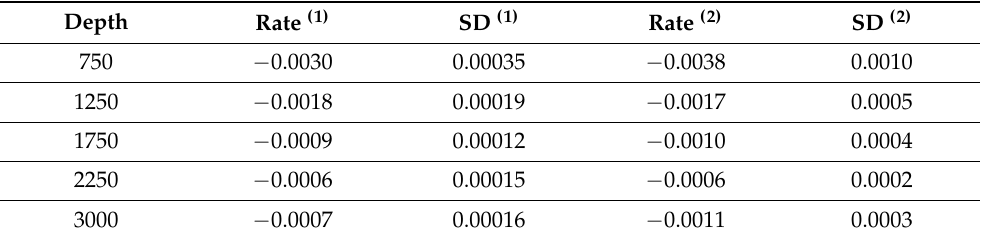
Table 1. Acidification rates (pH unit/year) of the JES at different depths in the north-western [36] and eastern parts (this